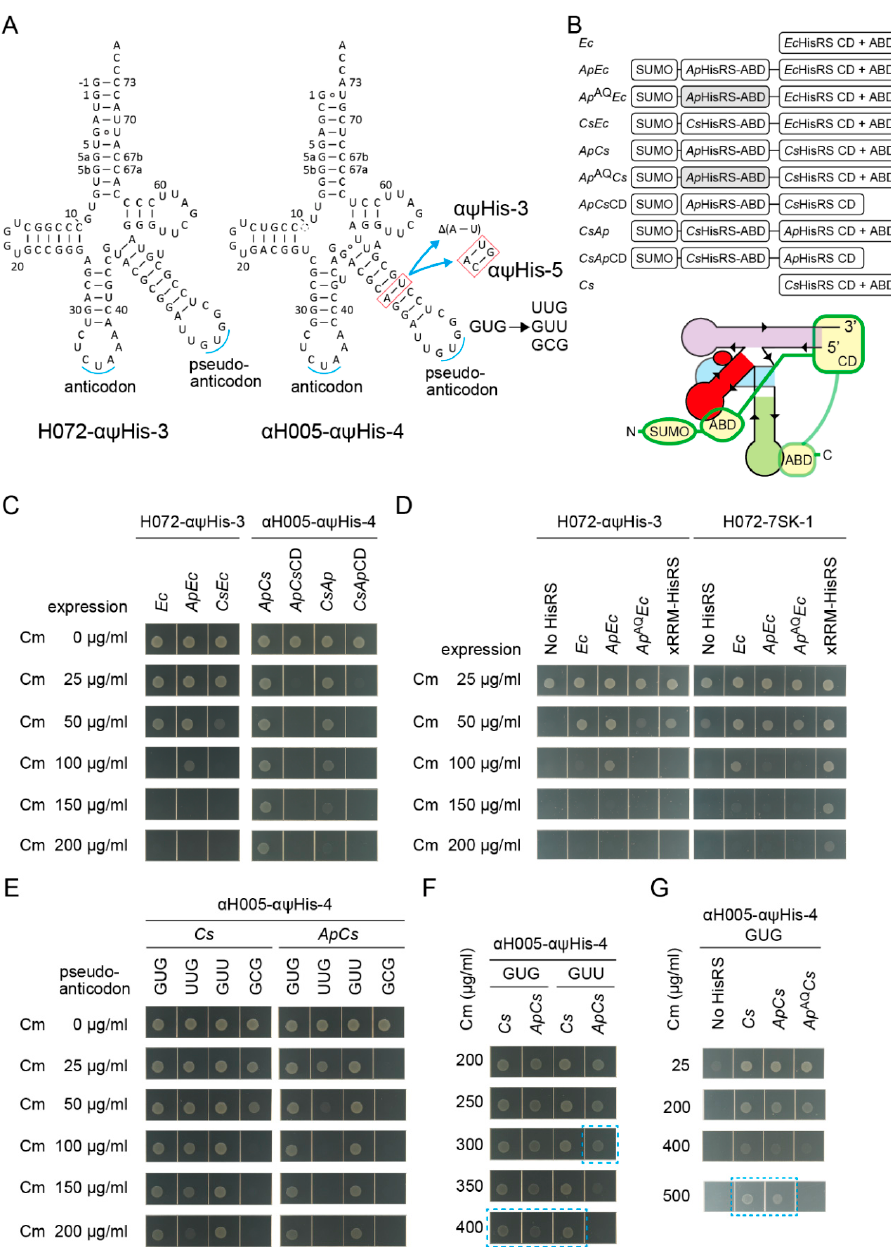
Figure 7. Recruiting HisRS via a pseudo-anticodon arm. ( A ) The cloverleaf structures of the H072- αψ His-3 and α H005- αψ His-3 / 4 / 5 variants with varying lengths of adaptors and with diverse pseudo-anticodon sequences. ( B ) The domain structures of HisRS and HisRS variants N -terminally fused with a heterologous anticodon binding domain (ABD). CD denotes catalytic domain. Ec , Ap , and Cs denote E. coli , Afifella pfennigii , and Consotaella salsifontis , respectively. Ap AQ denotes an Ap ABD variant carrying E484A-K493Q mutations impairing anticodon recognition. ( C , D ) Cm resistance of E. coli DH10B (NEB 10-beta) cells expressing the cat(His193TAG) reporter gene and the indicated combinations of HisRS and tRNA variants. ( D ) The His-inserting activity of H072- αψ His-3 was enhanced by ApEc but not enhanced by Ap AQ Ec , indicating that the recognition of the GUG pseudo-anticodon by the wildtype Ap ABD moiety was important. On the other hand, the His-inserting activity of H072-7SK-1 lacking the GUG pseudo-anticodon was not enhanced by both ApEc and Ap AQ Ec. No HisRS indicates that only the genomic hisS gene was expressing. ( E – G ) Cm resistance of E. coli DH10B (NEB 10-beta) cells expressing the cat(His193TAG) reporter gene and the indicated combinations of HisRS variants and pseudo-anticodon variants of α H005- αψ His-4. The Cm concentrations are indicated. ( G ) Note that the agarose plate containing Cm 500 µ g / mL was incubated for another four hours to obtain clear cell